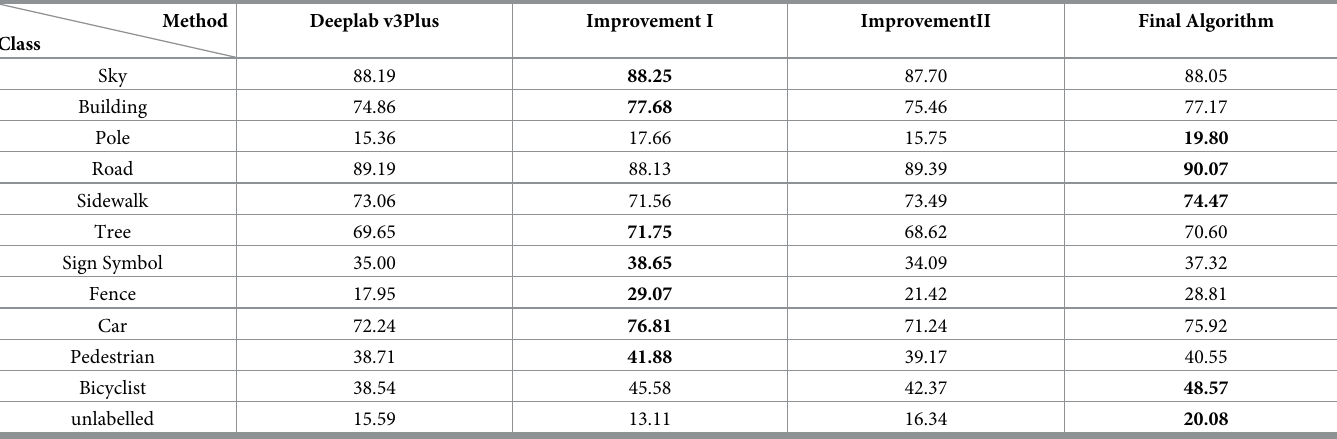
Table 5. Segmentation results of CamVid dataset experiment (unit: %).